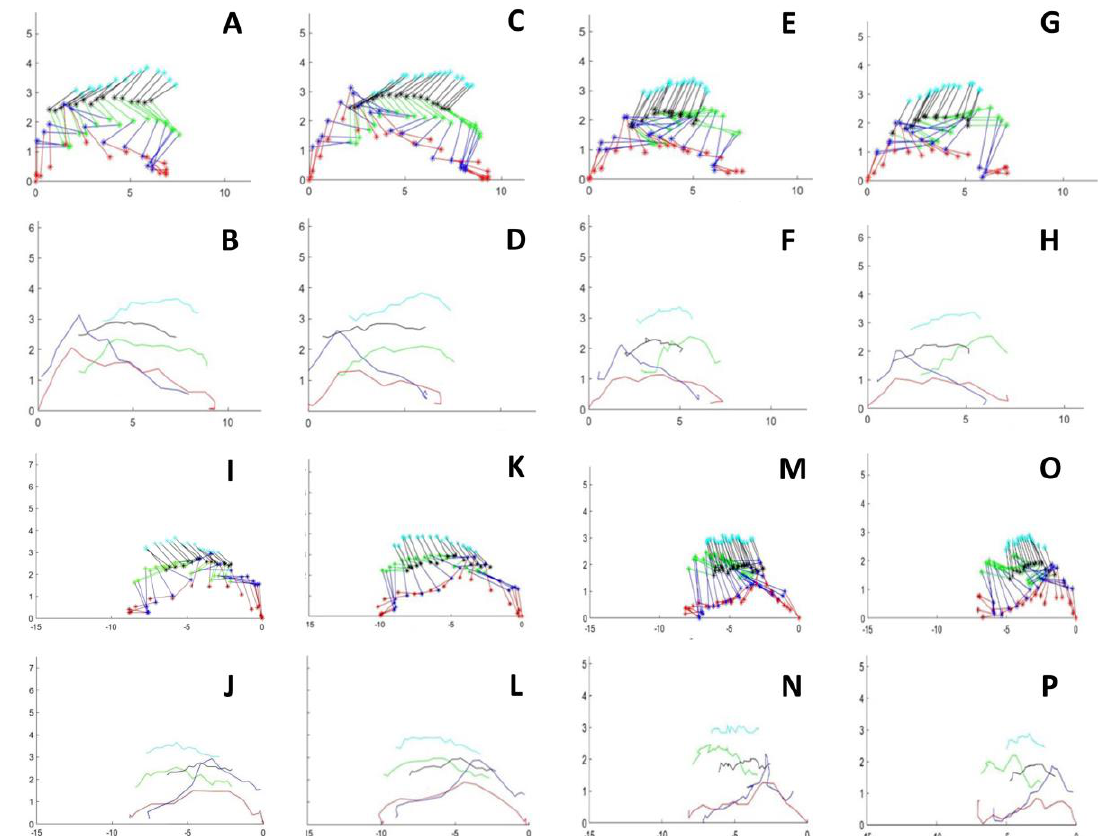
Figure 2. Stick figures of two consecutive steps of the right and left hindlimbs in control and an acute infected mice. Mouse walking from right o lefth an viceverse. ( A , C ) Two steps of right hindlimb walking from lefth to right in a control mouse. ( E , G ) Two steps of right hindlimb walking from lefth to right in an acute-infected mouse. ( I , K ) Two steps of lefth hindlimb walking from lefth to right in a control mouse. ( M , O ) Two steps of lefth hindlimb walking from lefth to right in an acute infected mouse. ( B , D ) and ( F , H ) illustrates the linear hindlimb displacement for each marked point in control and in an acute-mice, respectively. ( J , L ) and ( N , P ). Illustrates the linear hindlimb displacement for each marked point in control and in an acute-mice, respectively. Ordenates and abscissas for all graphs are in centimeters.